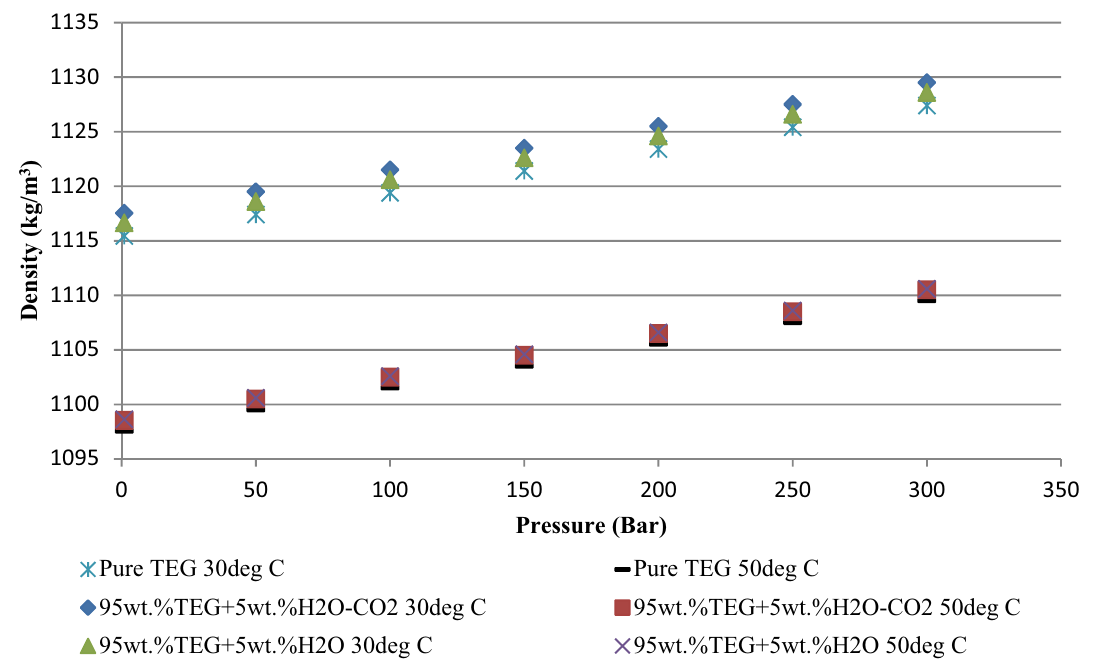
Fig. 4 Density of Pure TEG, 95wt%TEG + 5wt%Water and 95wt%TEG + 5wt%Water–CO